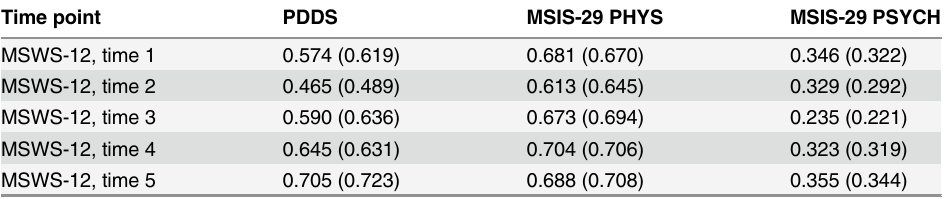
Table 4. Correlation coefficients for MSWS-12 scores with PDDS and MSIS-29 subscale scores across successive 6-month time periods in the sample of patients with RRMS.